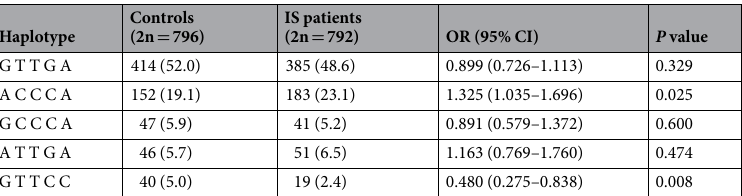
have a possible susceptibility to increase the expression of serum S100B. In contrast, Yang et al . 39 showed that the rs9722 polymorphism was not correlated with the risk of major depressive disorder in a Chinese population. To date, no association study has been reported on the association between the rs9722 polymorphism and IS. However, in this study, we found that the rs9722 AA genotype, dominant, recessive and additive model display an increased risk of IS. Additionally, the levels of serum S100B were found to be elevated in IS patients. Interestingly,